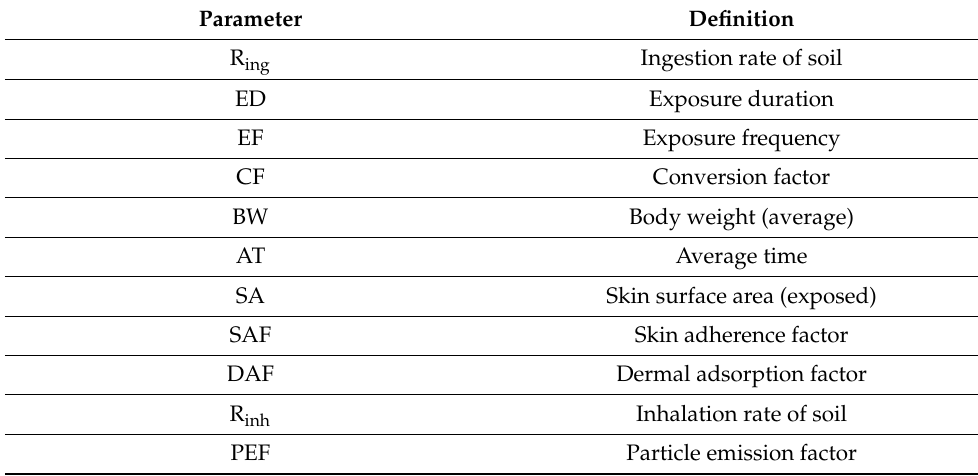
Table 15. Exposure parameters for health risk assessment [160].